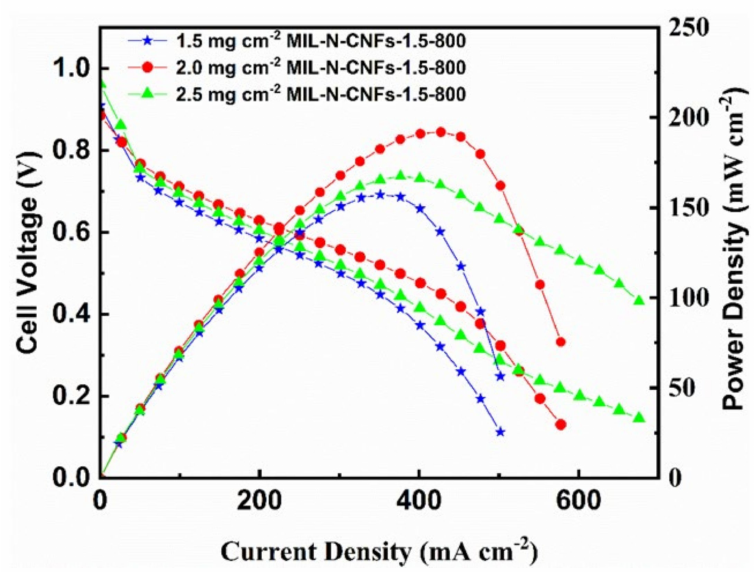
Figure 5. The polarization curves and power density in H 2 /O 2 anion-exchange membrane fuel cells. MIL-N-CNFs-1.5-800 was used as cathode catalyst and 60% Pt-Ru/C as anode catalyst. MIL-N-CNFs- 1.5-800 loadings: 1.5, 2 and 2.5 mg cm − 2 . The 60 wt.% Pt-Ru/C loading: 0.4 mg cm − 2 . T = 80 ◦ C, cathode RH = 100%, anode RH = 100%, back pressure = 0